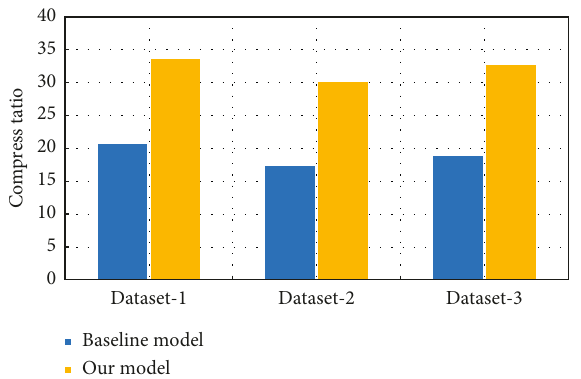
Figure 8: Write-only instance storage space data compression comparison